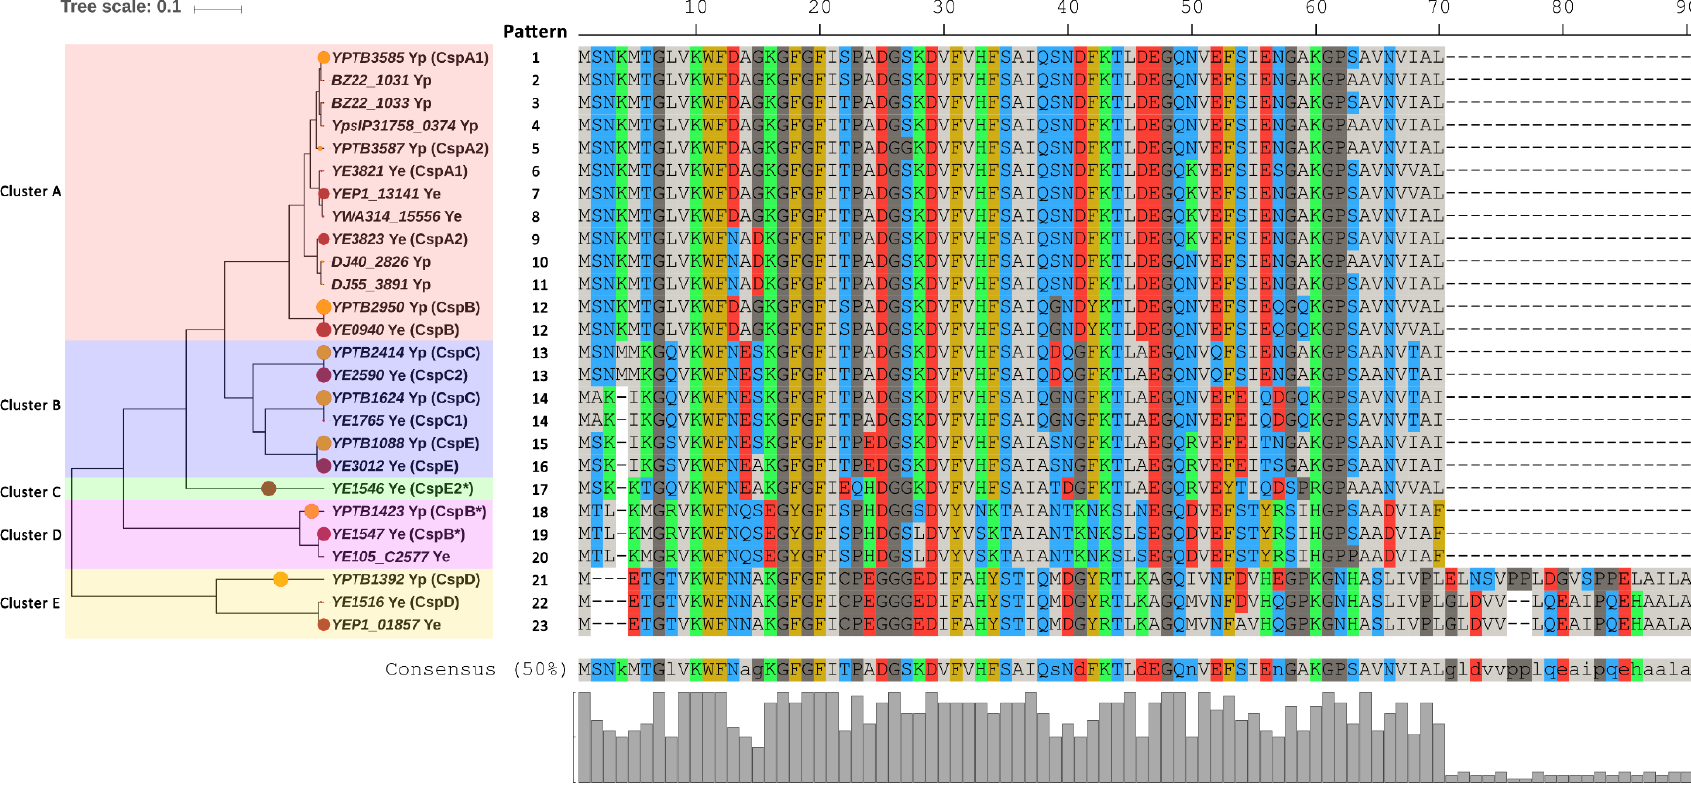
Figure 1. Phylogenetic cluster of Csp sequence patterns in enteropathogenic Yersinia . A phylogenetic tree composed of representative Csps of sequence patterns in enteropathogenic Yersinia . Circle radii represent the abundance ratios of each Csp pattern in Y. pseudotuberculosis (orange) or Y. enterocolitica (brown). Most Csps were named using the convention of E. coli , if any, except those marked with an asterisk. Histogram shows conservation of Csp sequence.